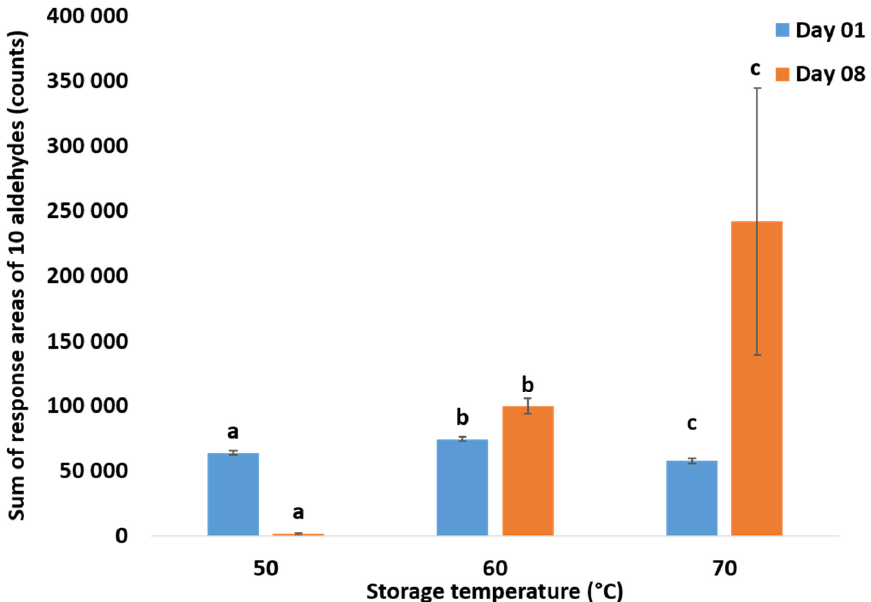
Figure 2. Impact of storage temperature on the sum of volatiles (response areas) determined by solid-phase microextraction (SPME)-GC-MS in a liquid infant milk formula. Samples were stored in the dark for 8 days at 50, 60, and 70 °C and contained no antioxidants. Values are presented as means. Error bars are standard deviations of three repetitions. Means with different letters within the same day are significantly different (one-way ANOVA p < 0.05; factor: storage temperature (°C)). Foods 2020 , 9 , x FOR PEER REVIEW Two preparations of infant milk formulas were studied. The first recipe (No-AOx) did not contain antioxidants. As for the second one (AOx), a mixture of ascorbyl palmitate (E304), citric acid (E330), and lecithin (E322) as a surfactant was used. Figure 3 shows a comparison between these two formulations after storage at 70 °C for 8 days. Even at 70 °C, the antioxidants mixture had a preventive effect. The total sum of volatiles remained stable after 8 days.